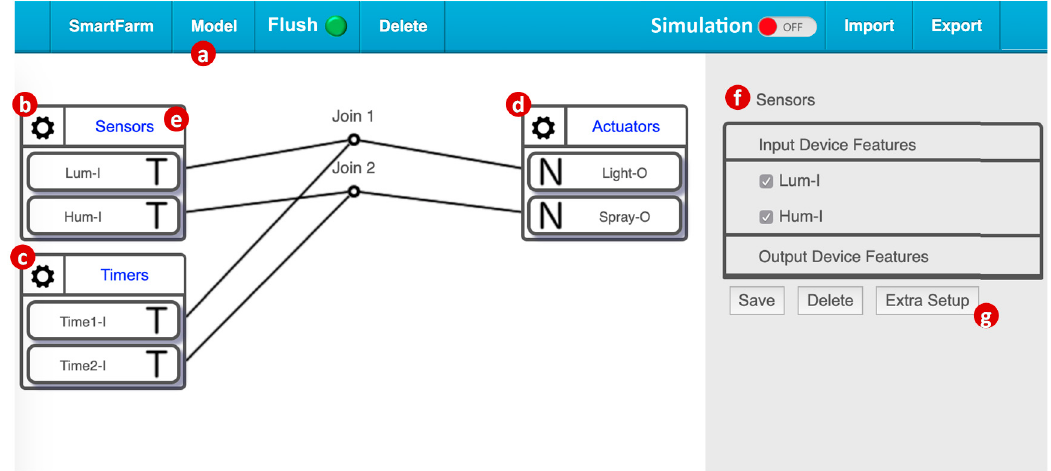
Figure 3. IoTtalk configuration for the smart farm service.